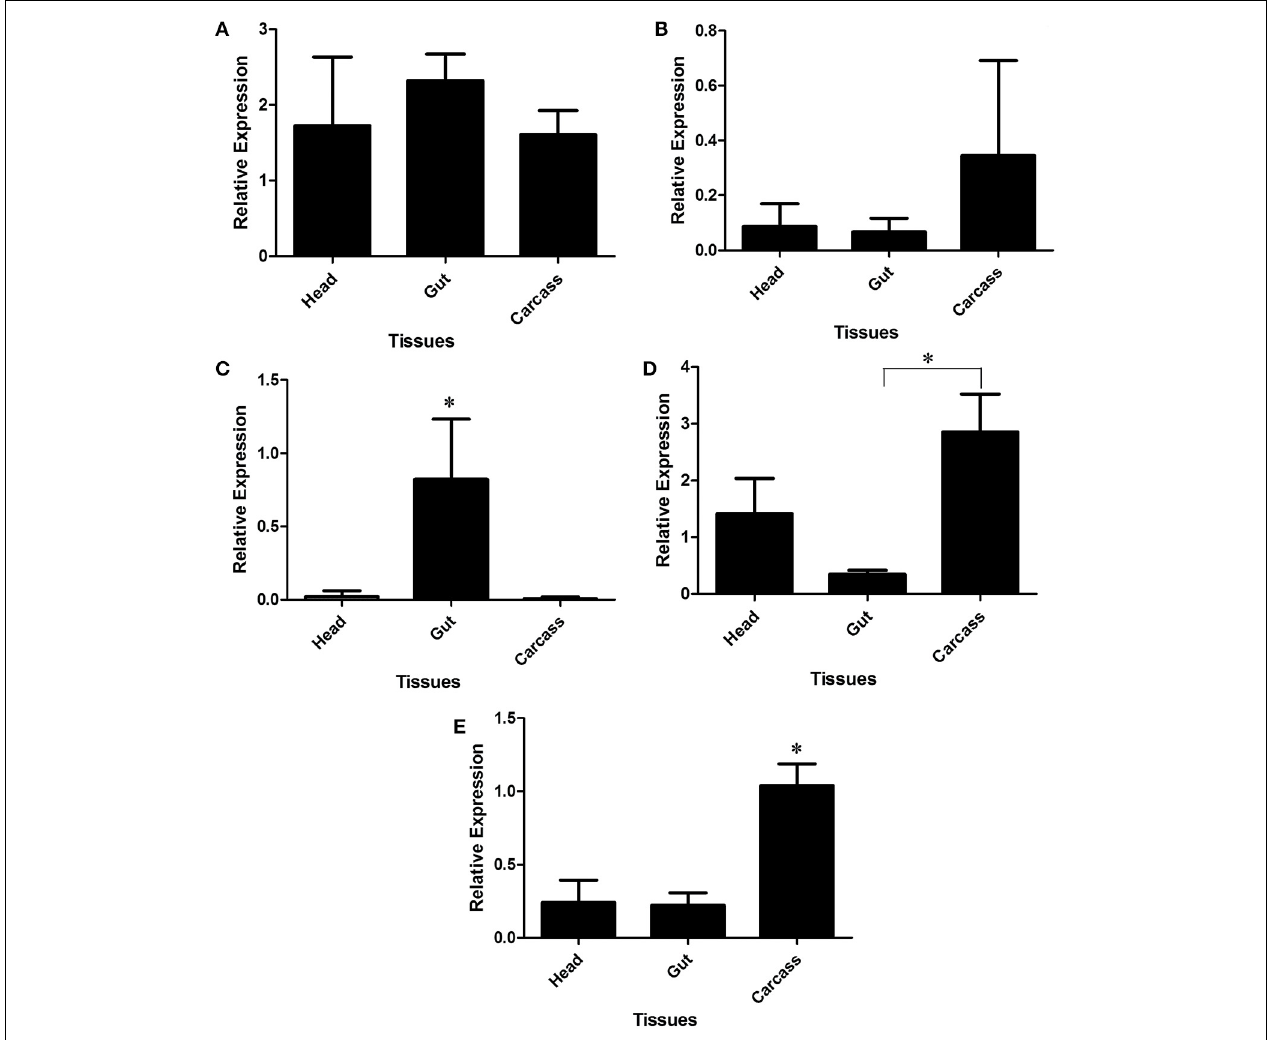
FIGURE 8 | Relative expression of GHF18 chitinases and chitinase-like proteins in different tissues of Lutzomyia longipalpis L4 larvae as determined by Multiplex RT-PCR (Ribosomal protein 60 used as constitutive gene). Chitinases amplified were: (A) LlChit2; (B) LlChit3; (C)